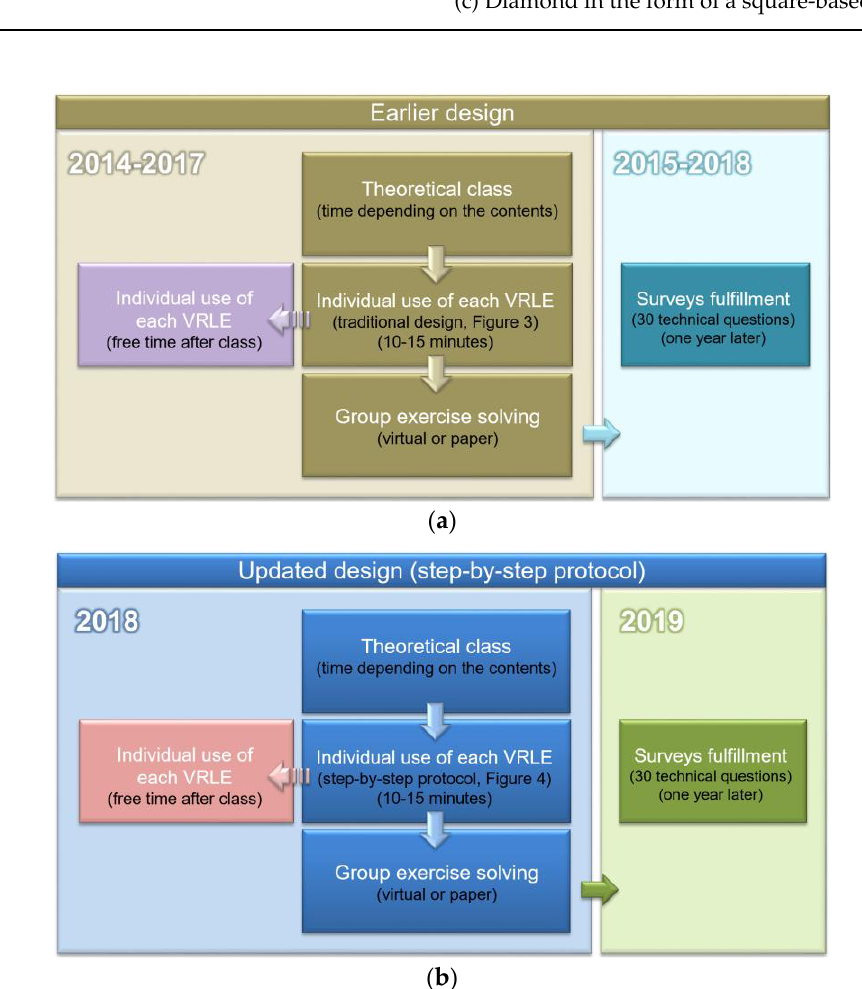
Figure 5. Schematic of the methodology followed in the present study: ( a ) during 2015 – 2018; and ( b ) in 2019.